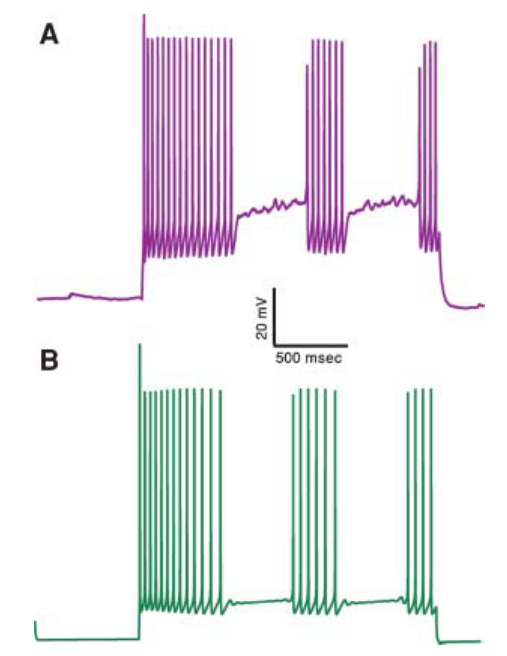
Figure 7. A proof of principle: generating an additional electrical class – stuttering neurons . (A) Experimental response of a stuttering interneuron to 2seconds long, 150pA depolarizing current (Markram et al., 2004). (B) Response of a model for this cell type to the same current input. A feature that measures the number of pauses in the firing response has been added to the other six features used before. This demonstrates that with this addi- tional feature one can obtain a qualitative fit of the stuttering electrical class. The values of the channel conductances (in mS/cm 2 ) obtained in this fit are: Na t =479; Na p =0; K fast =482; K slow =477; I A =99; Kv3.1=514; Ca=6.57; SK=85.4; I h =0; I m =2.36; Leak soma =0.00684; Leak dendrite